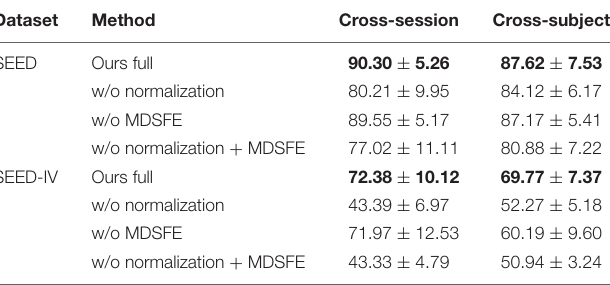
TABLE 5 | Ablation study of MSMRA on SEED and